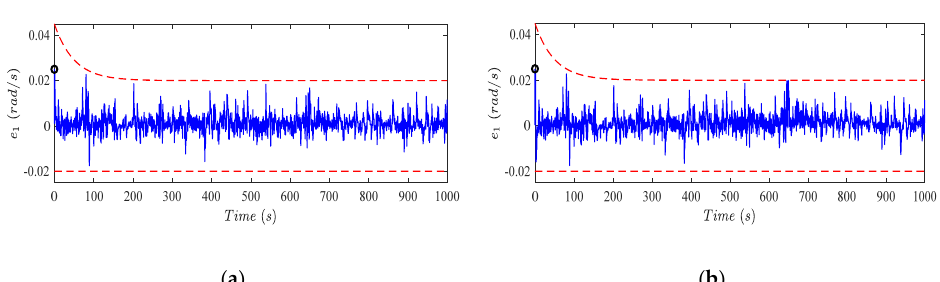
Figure 4. Tacking error e 1 (blue line) with constructed constraints (red dashed lines), under single ( a ) and simultaneous faults ( b ). The circle represents the initial